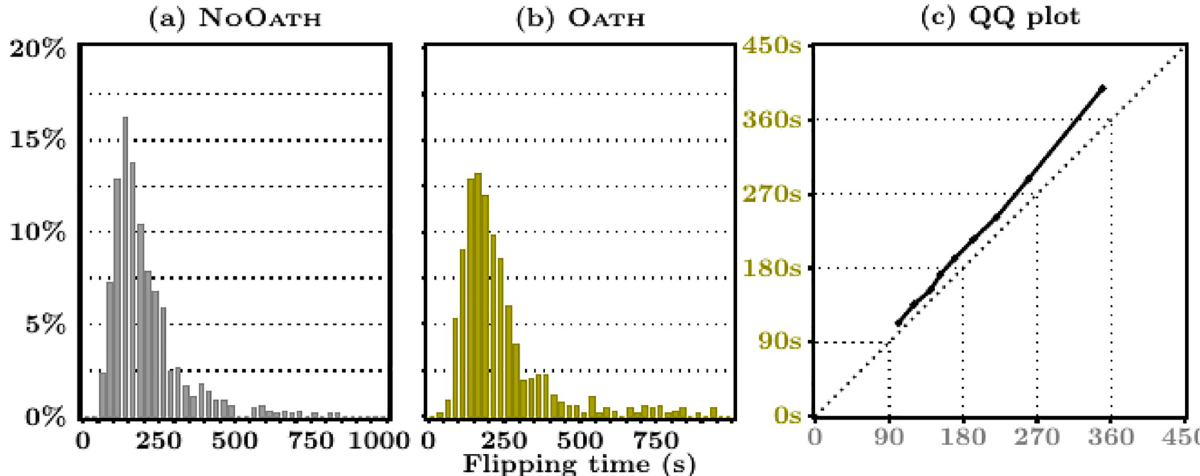
Fig 3. Empirical distribution of survey duration, by treatment. Note . The left-hand side figures report the empirical distribution of survey overall duration, net of flipping time. To ease readability, 13 workers for whom this duration is higher than 1000s were dropped to construct these figures. The figure on the right-hand side displays the QQ plot of the deciles of the net survey duration in the N O O ATH treatment (on the x-axis) against the O ATH one (on the y-axis).